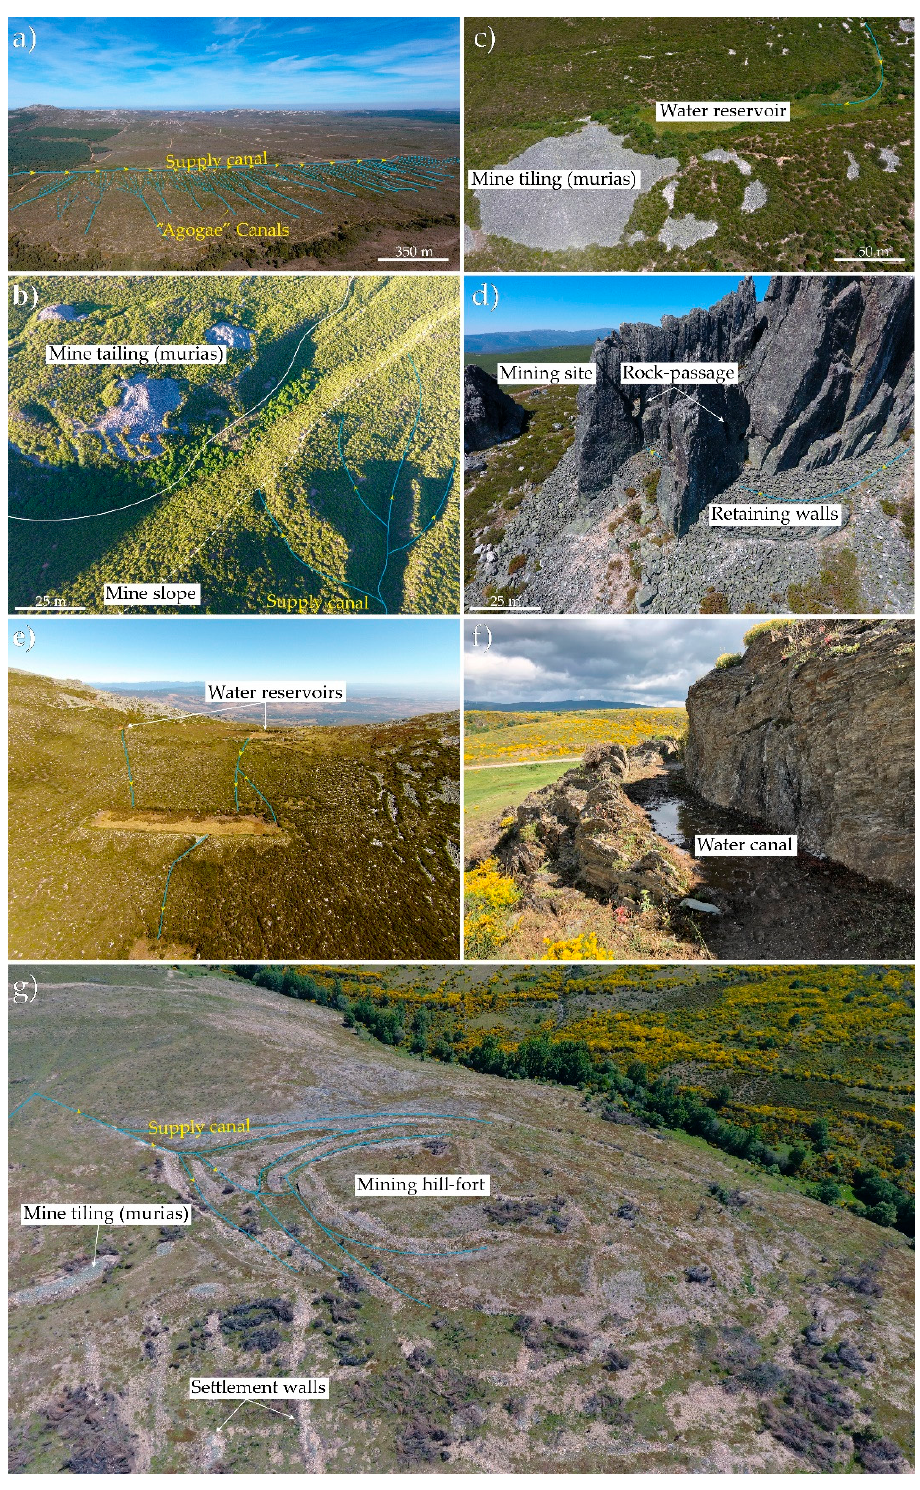
Figure 6. Oblique aerial images of the study sectors: ( a ) comb-like open-cast mine at Castrocontrigo (Model 1); ( b ) Deep open-cast mine (Model 2); ( c ) Murias deposits supporting a water reservoir (Model 3); ( d ) rock tunnel (Model 4); ( e ) water reservoirs (Model 5); ( f ) water supply canal (Model 6) and ( g ) a mining camp (Model 7).